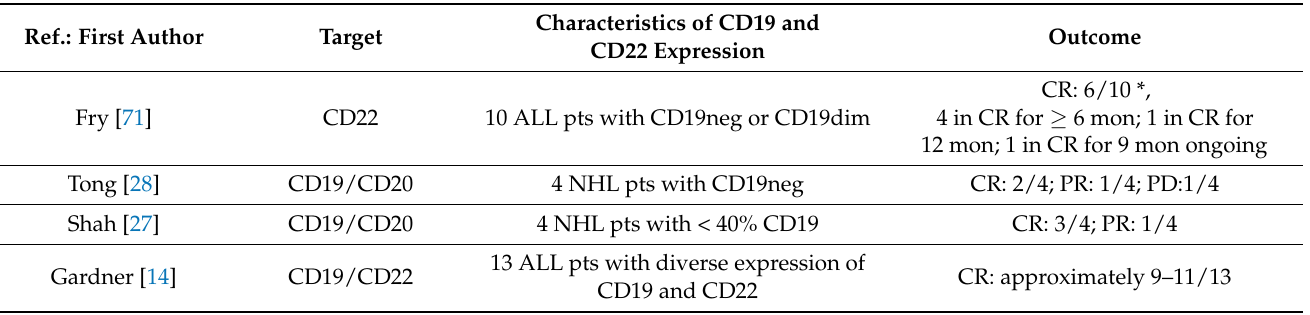
Table 5. Outcomes in patients with negative or low-CD19 expression after treatments with CD22 Si-CAR T-cell therapy and CD19/CD20 Bi-CAR T-cell